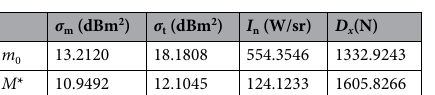
Table 4. Aircraft main performance comparison before and after CDM.